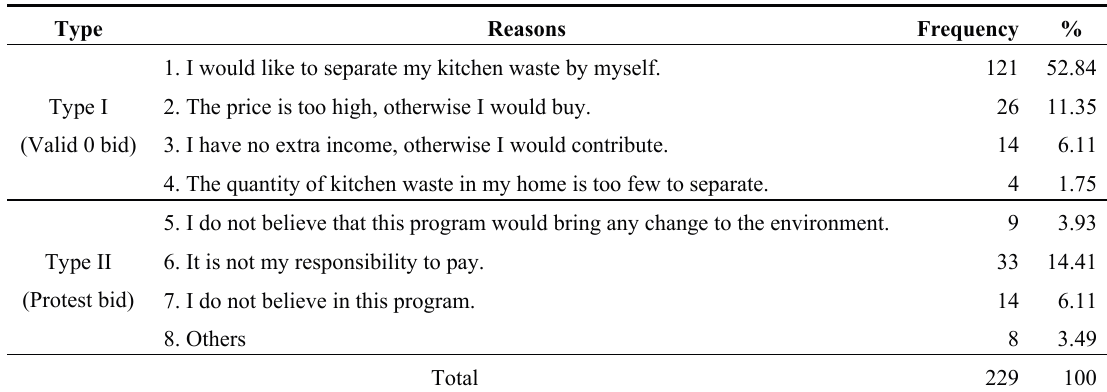
Table 3. Frequency of reasons for responses who would not pay or were not sure about paying for the HKWS services.